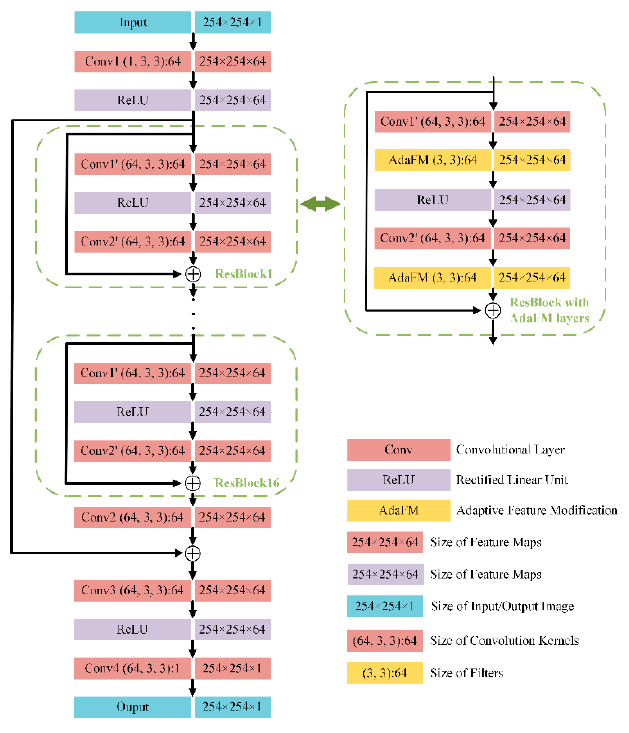
Figure 3. The architecture of deep residual convolutional neural network (CNN).